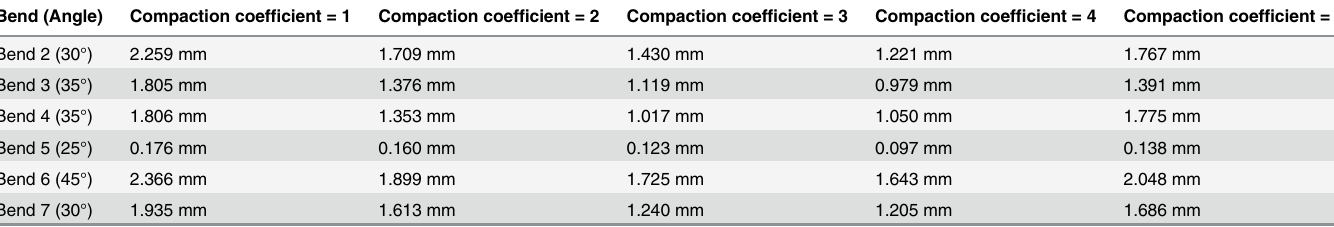
Table 16. Comparison of longitudinal displacements of bends (25°- 45°) with different Compaction coef fi cients. Bend